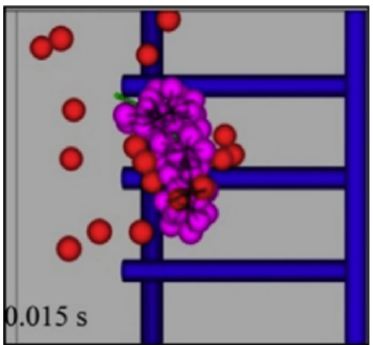
Figure 3. Grape picking process modeling [128].